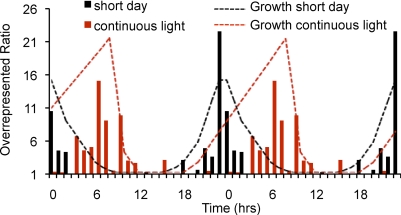
Shade-Avoidance Genes Overrepresented during the Growth PhaseGenes misregulated using shade avoidance–like conditions are expressed at dawn and dusk, specifically under short-day photocycles (black) and continuous light (red). Overrepresentation ratio is double plotted for visualization purposes. Shade-avoidance microarray data were reanalyzed from Sessa et al. 2005 [36]. The growth curves for short-day photocycles (black dotted lines) and continuous light (red dotted lines) are reproduced for frame of reference.